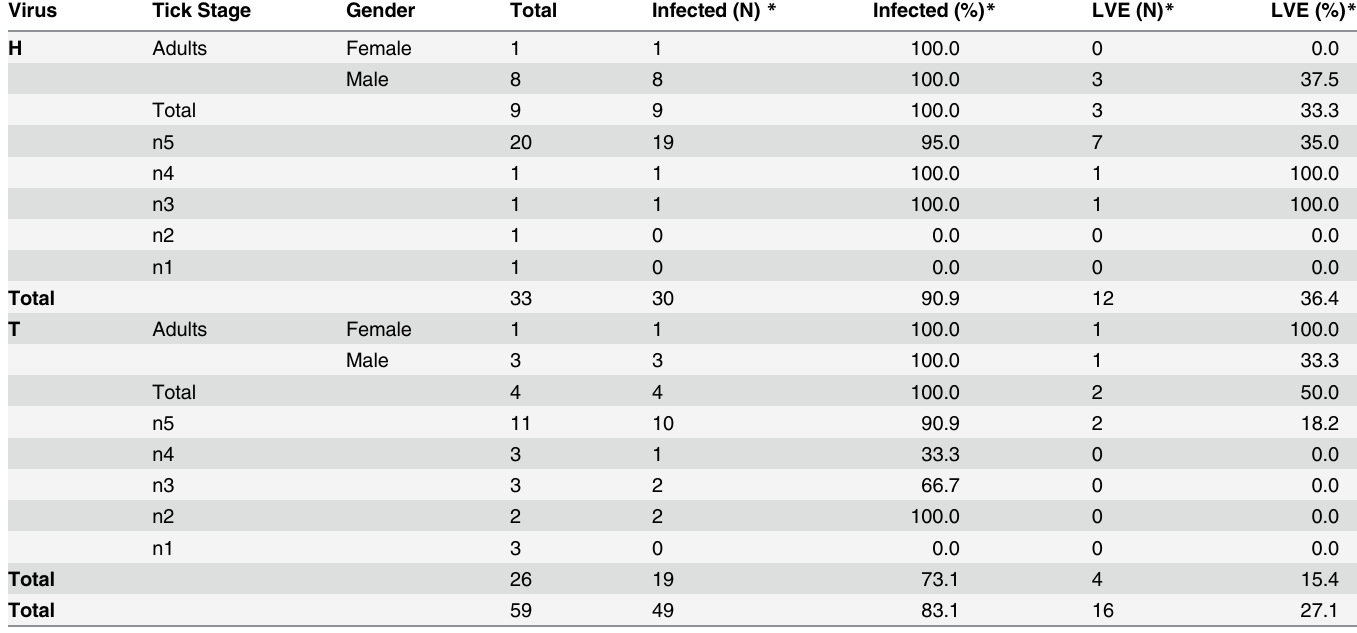
Table 2. Proportion of ticks fed on pigs with high blood titres of viruses H and T that became infected and with high likelihood of virus excretion (LVE). Virus Tick Stage Gender